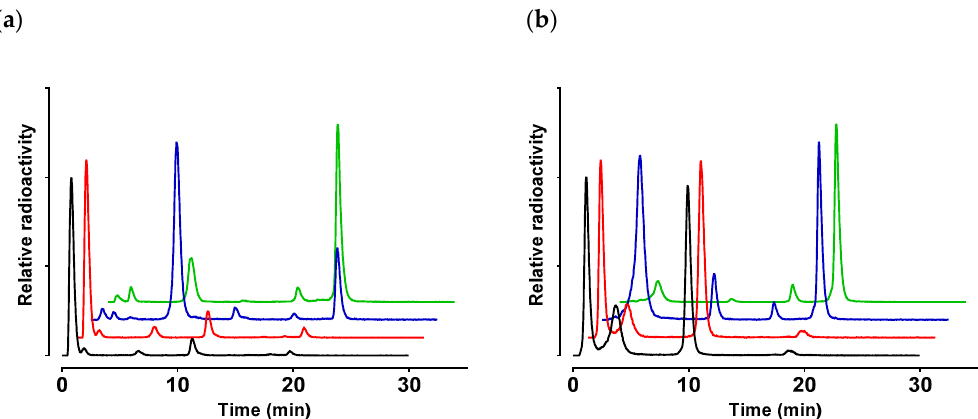
Figure 4. Representative radiochromatograms of HPLC analysis of mouse blood samples collected 5 min pi with ( a ) [ 99m Tc]Tc–DT1 and ( b ) [ 99m Tc]Tc–DT5; black line graphs correspond to samples from untreated controls, red line graphs to samples from animals receiving per os Entresto 30 min prior to radioligand injection, blue line graphs to samples from animals with Lis co-injected together with the radioligand, and green line graphs to samples from animals receiving Entresto 30 min prior to radioligand co-injection with Lis (HPLC system 2); percentages of intact radioligand are summarized in Table